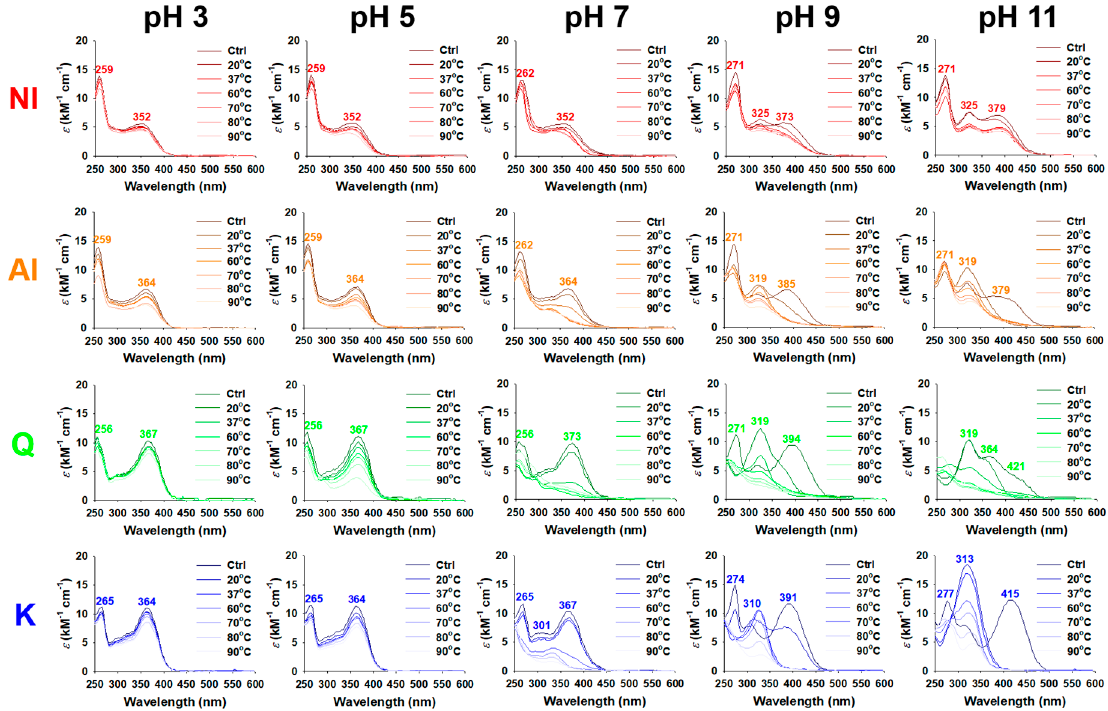
Figure 2. UV / visible spectra (250–600 nm) of the non-hydrolyzed isolate (NI) and acidolyzed isolate (AI) of Ginkgo biloba leaf, quercetin (Q), and kaempferol (K) at various pH ranges (3–11) and temperatures (20–90 °C) during 18-h incubation. Ctrl, control.